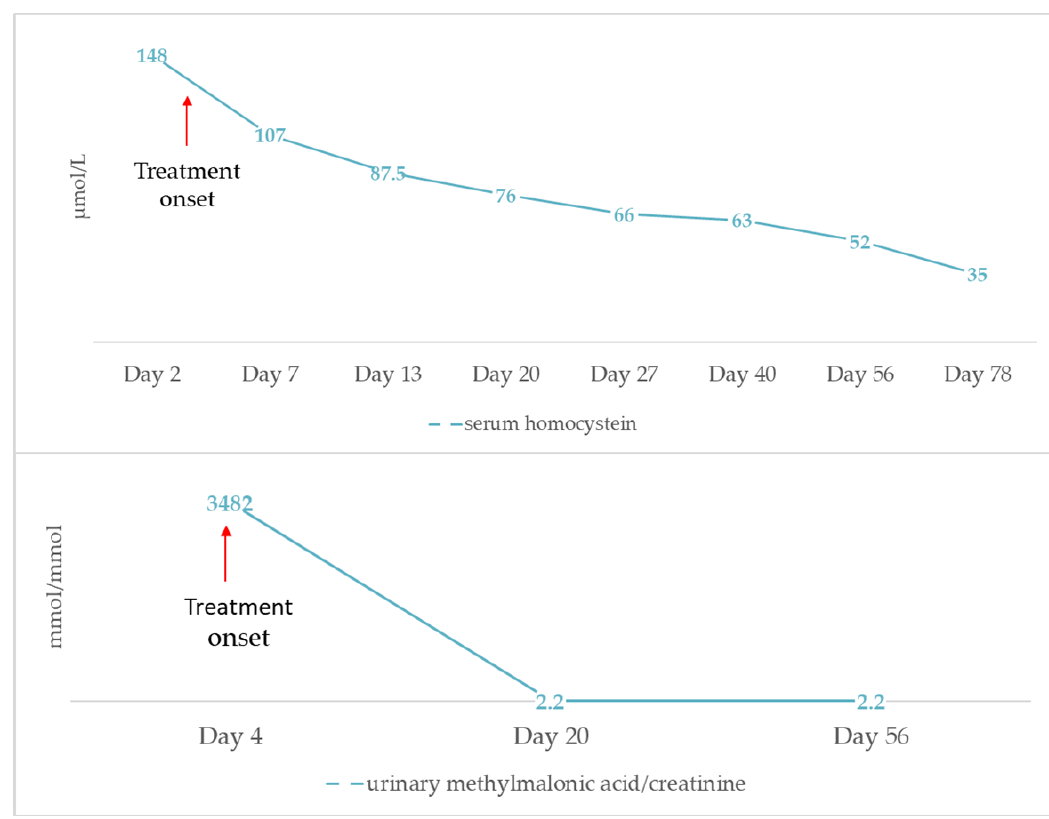
Figure 1. Progression of serum homocysteine and urinary methylmalonic acid levels after initiation of treatment with hydroxycobalamin, betain, folic acid and L-carnitine .